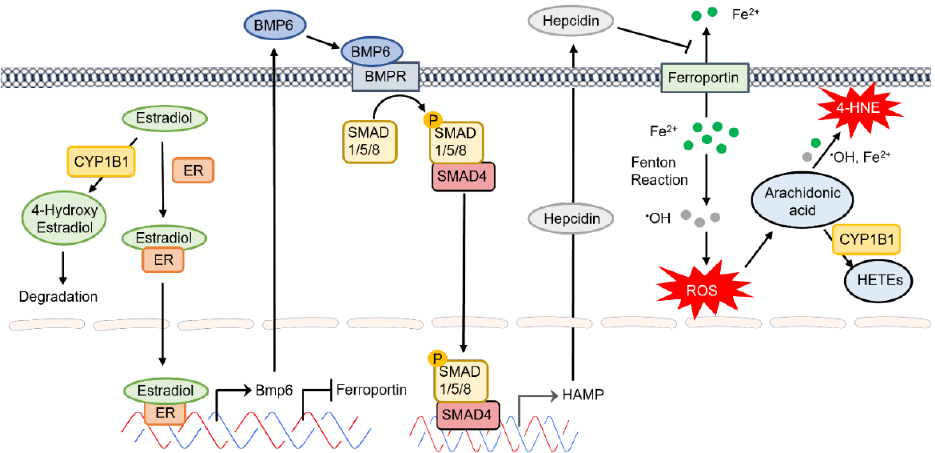
Figure 5. The proposed CYP1B1 regulation of intracellular iron levels and oxidative stress through estradiol metabolism, BMP6 signaling, hepcidin production, and ferroportin inhibition in the reti- nal